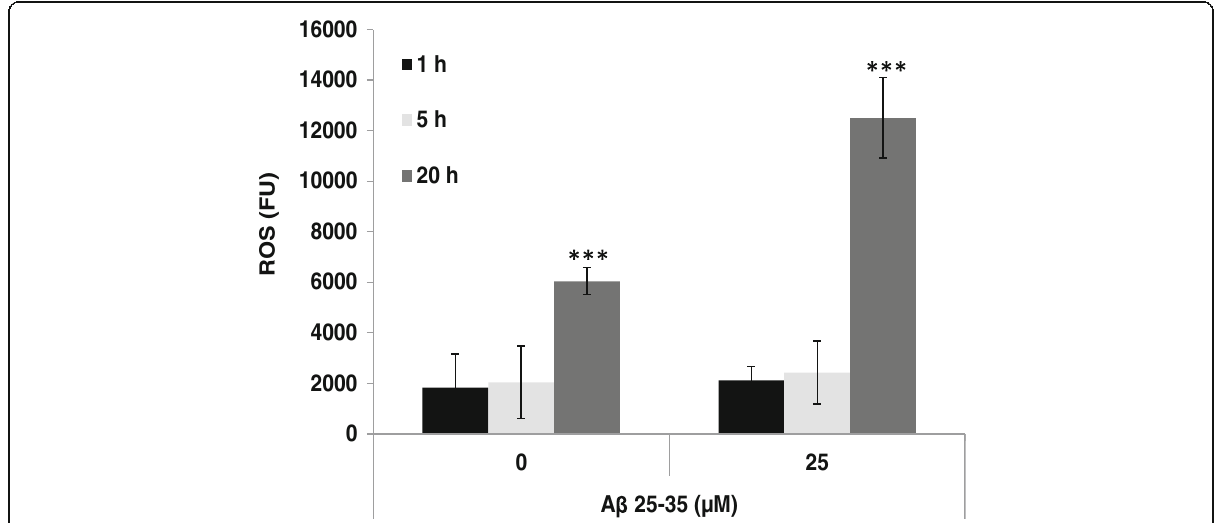
Fig. 3 A β -induced elevation in ROS levels in N2a cells. Intracellular ROS levels (Fluorescence units, FU) were measured 1, 5, and 20 h after treatment. The results are the mean ± SEM of one experiment ( n = 8)